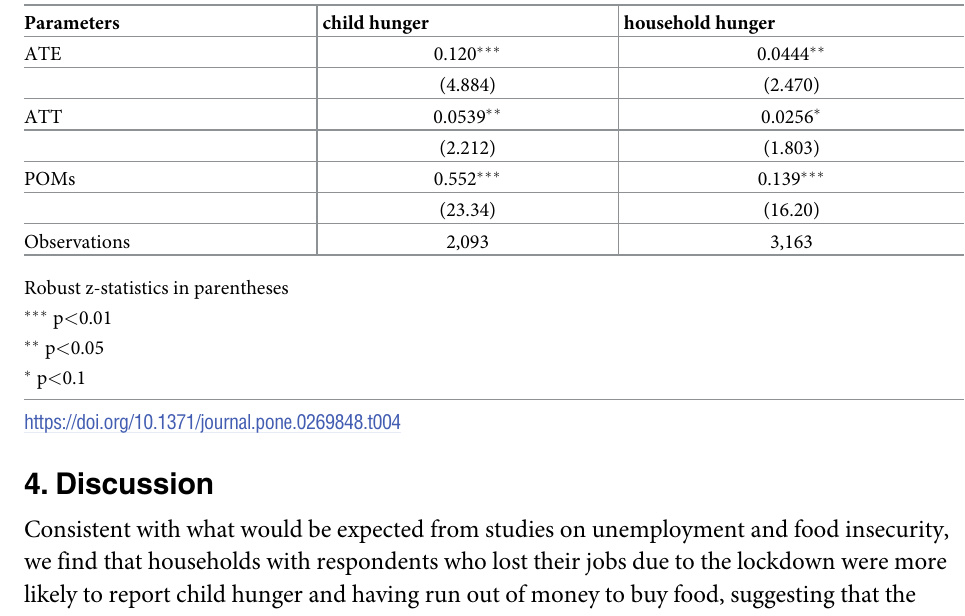
Table 4. Telasso (machine learning) estimates of food